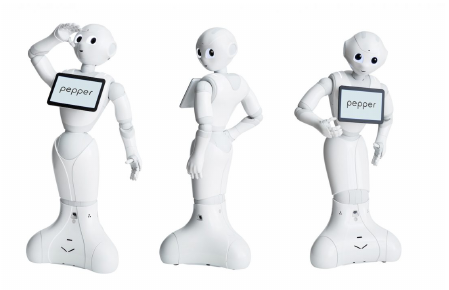
Figure 1. The social robot used in this work.